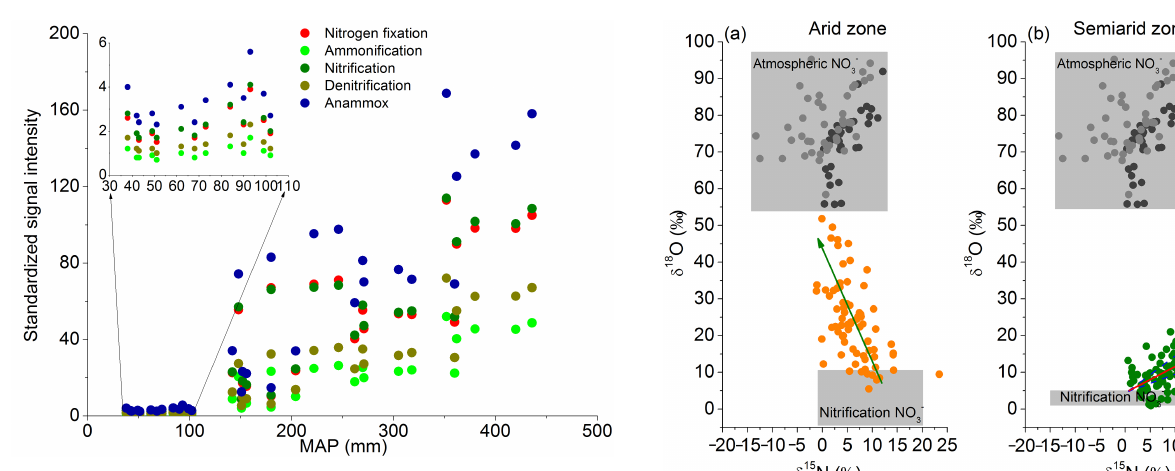
Figure 4. Changes in the abundance of microbial gene involved in N cycling. Signal intensity was standardized based on both the number of array probes and DNA quantity in a gram of dry soil. Each point is the site-averaged value; results of the abundance of nitrification and denitrification genes were reported in a previous study (Wang et al., 2014).